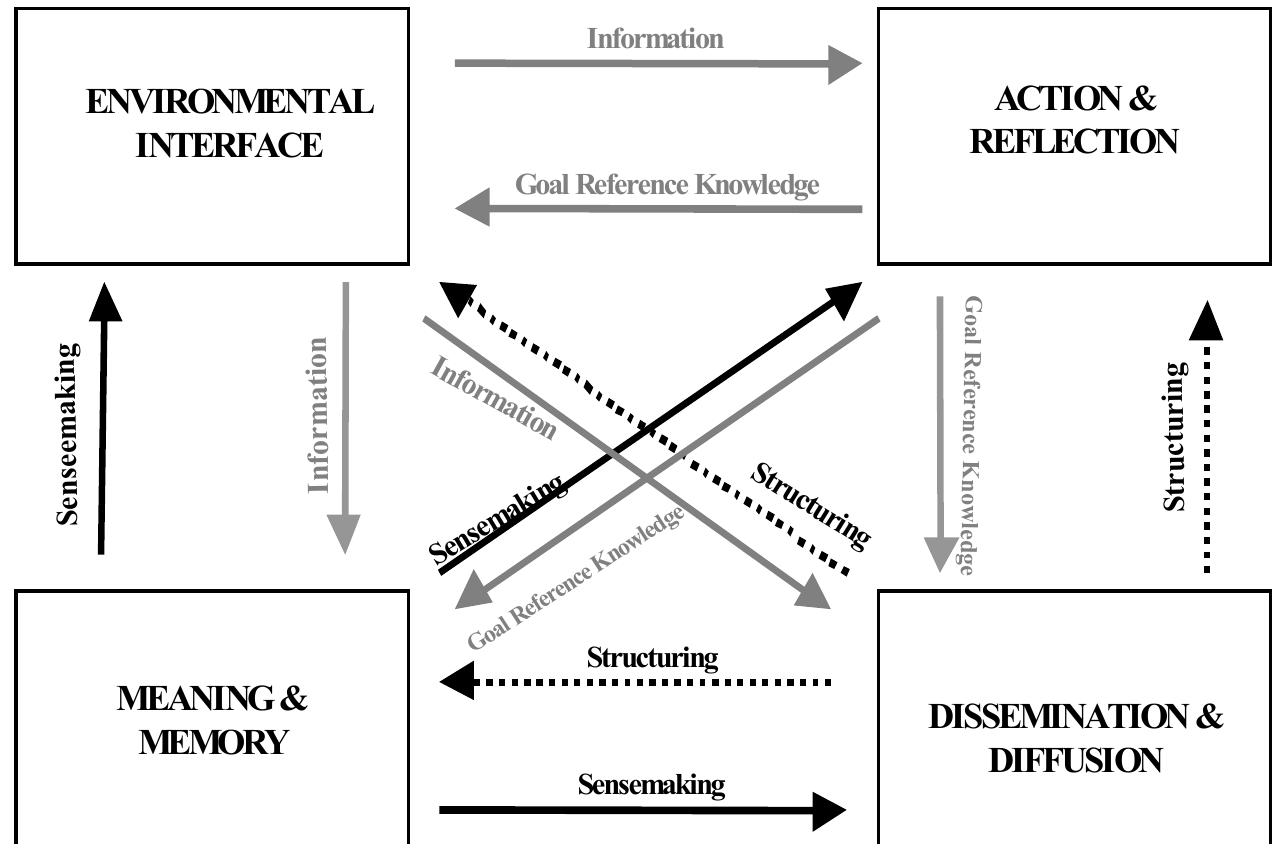
Figure 2: Media of interchange in Schwandt’s learning subsystems Conclusion 11: Formal actions related to education and developments were not taken but the KMT recognized them as important